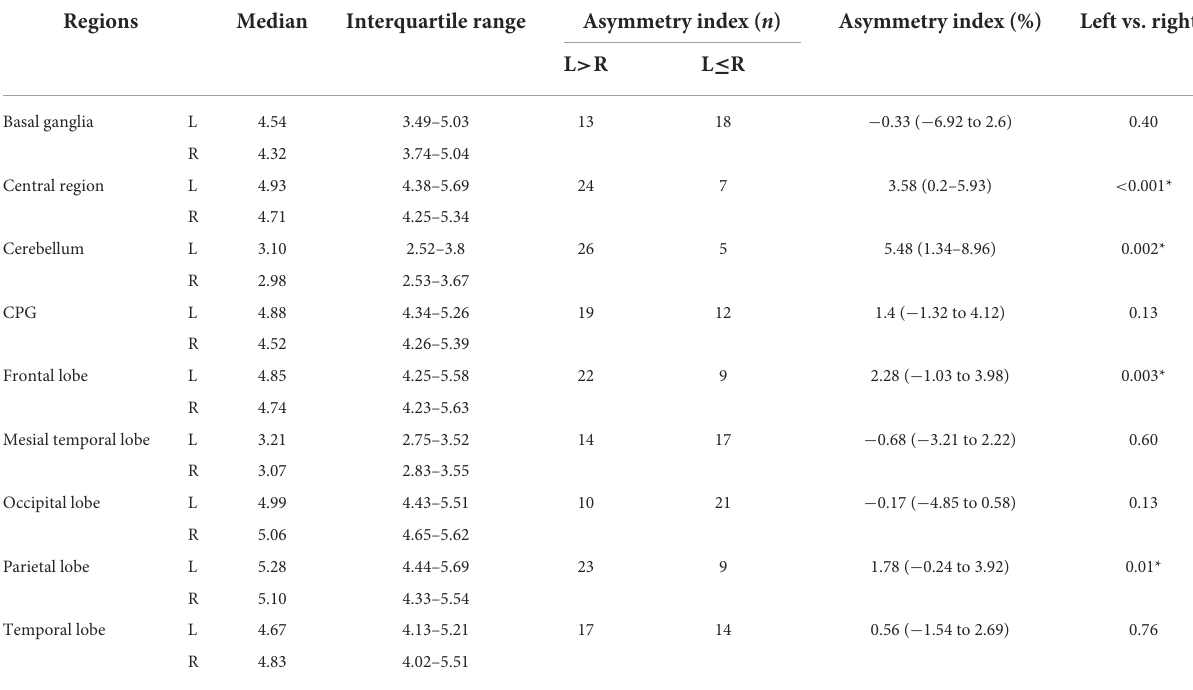
TABLE 2 Cerebral metabolic ratio and asymmetry index in CP patients. Regions Median Interquartile range Asymmetry index ( n ) Asymmetry index (%) Left vs. right* L > R L ≤